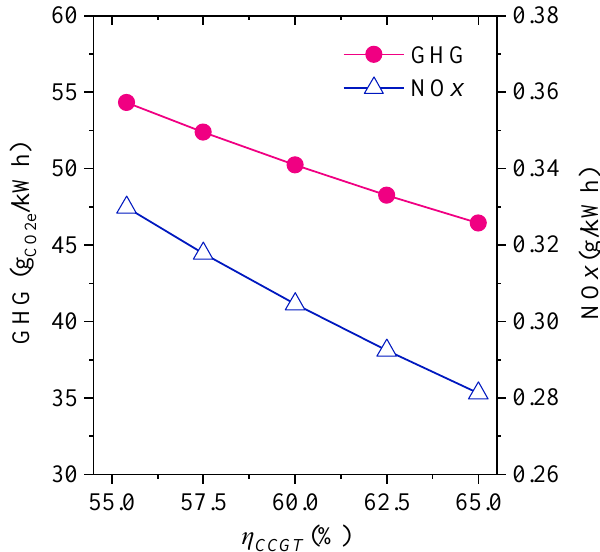
Figure 5. Variations in life cycle of GHG and NO x emissions with η CCGT .